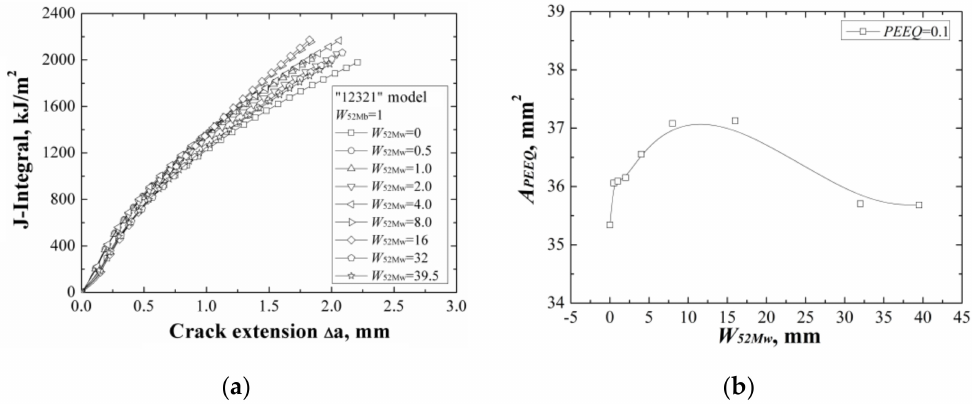
Figure 11. The J -resistance curves ( a ) and the areas surround by the ε p = 0.1 isoline ( b ) of different “12321” models with the same W 52Mb